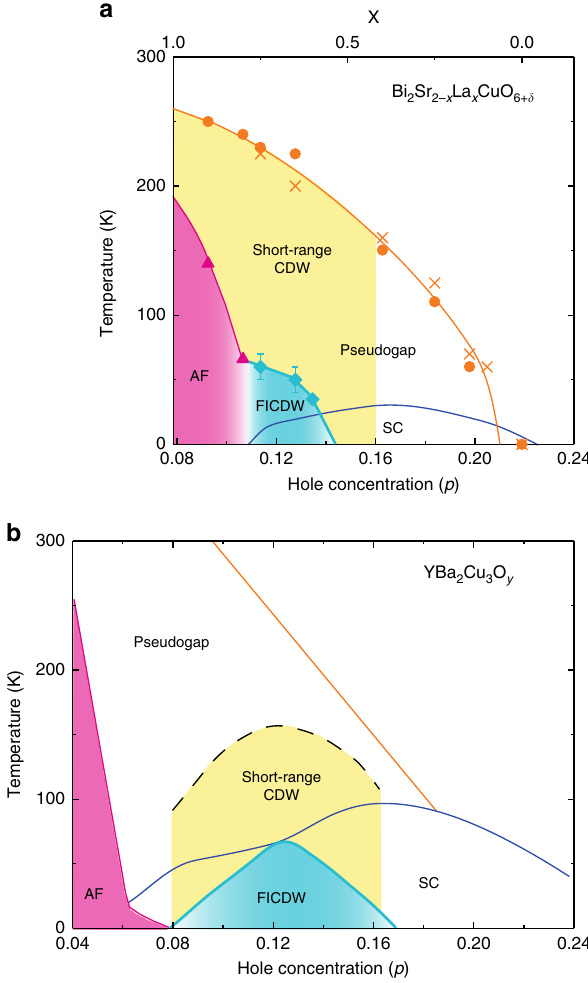
Fig. 7 Phase diagram of Bi2201 compared with YBCO. Doping dependence of the short-range CDW reported by the X-ray measurements 2,12,16 and the fi eld-induced CDW (FICDW) for Bi2201 a and YBCO b . For both cases, T fi eld value. Error bars represent the uncertainty in de fi ning c is the zero- T CDW . The schematic phase diagram for YBCO is from the literatures